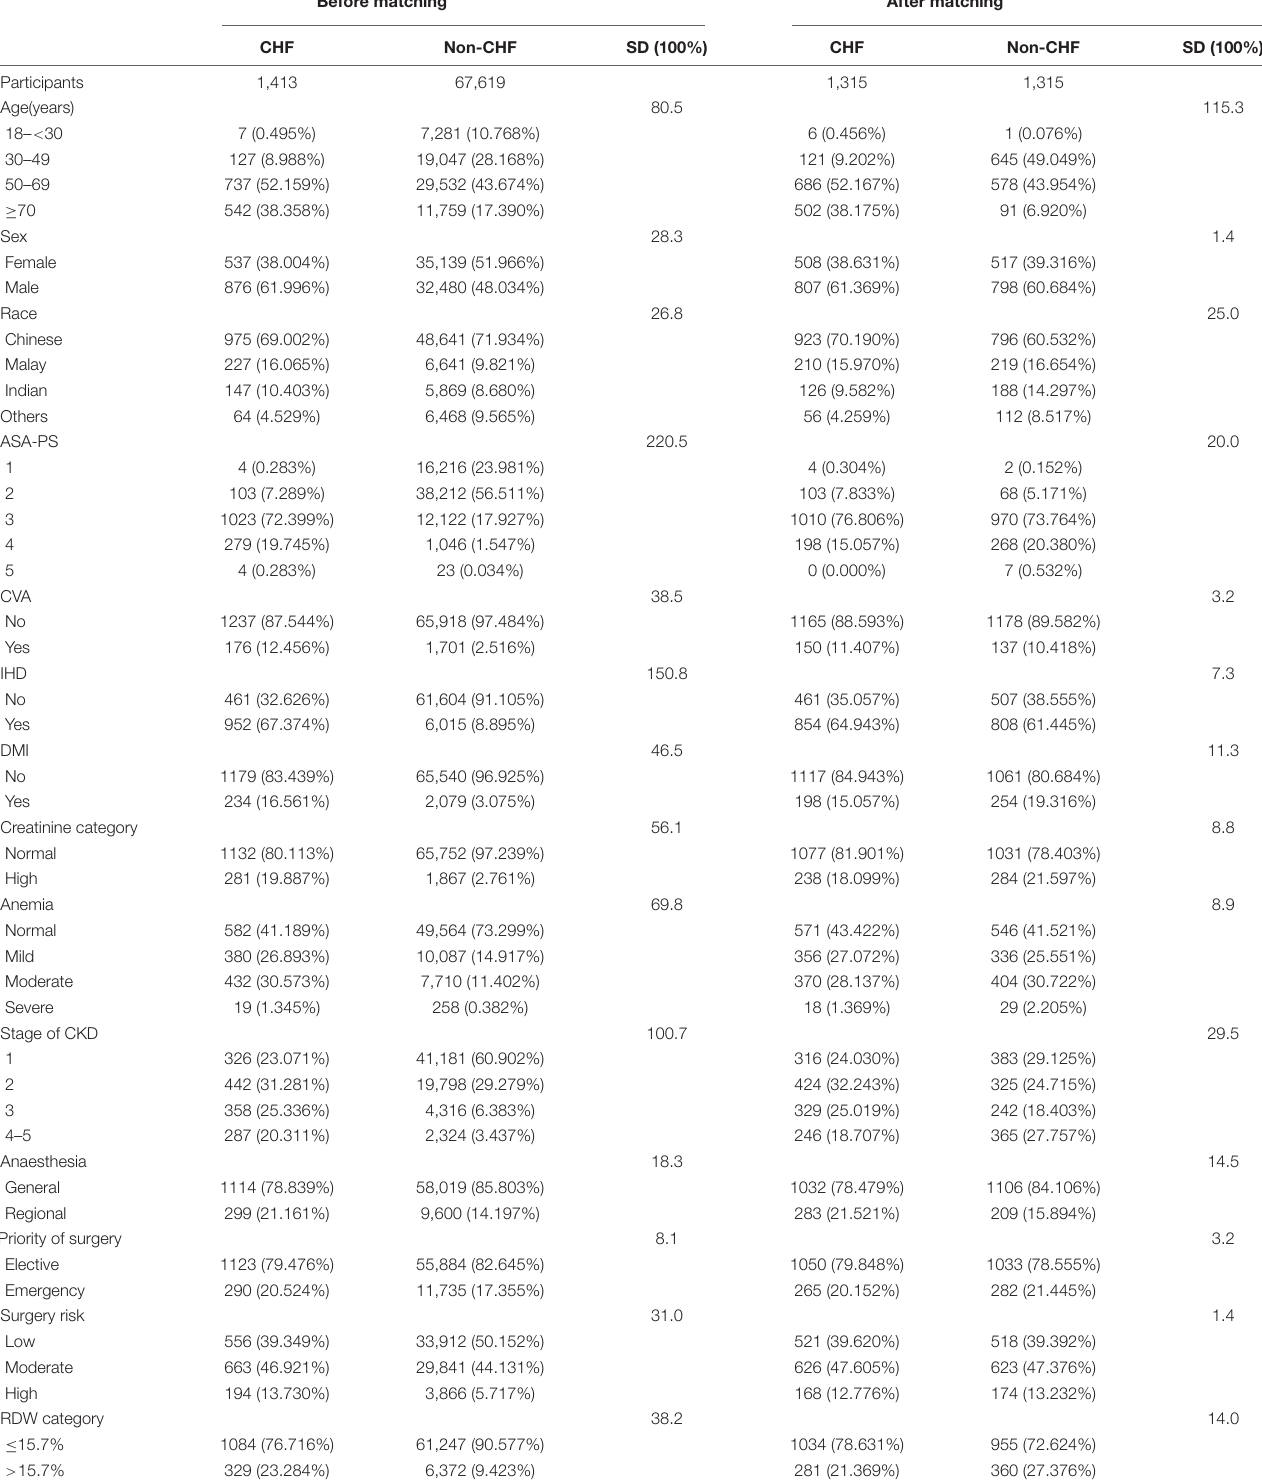
TABLE 1 | Baseline characteristics before and after propensity score